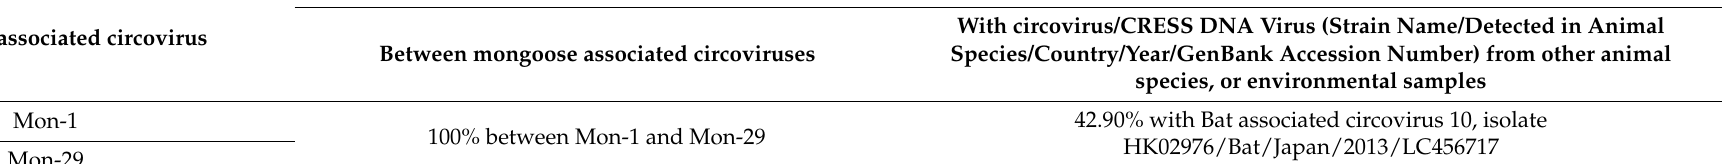
Table 4. Maximum deduced amino acid (aa) sequence identities of the putative capsid proteins (Cp) of mongoose associated circoviruses and cycloviruses between themselves and with those from other animal species, or environmental